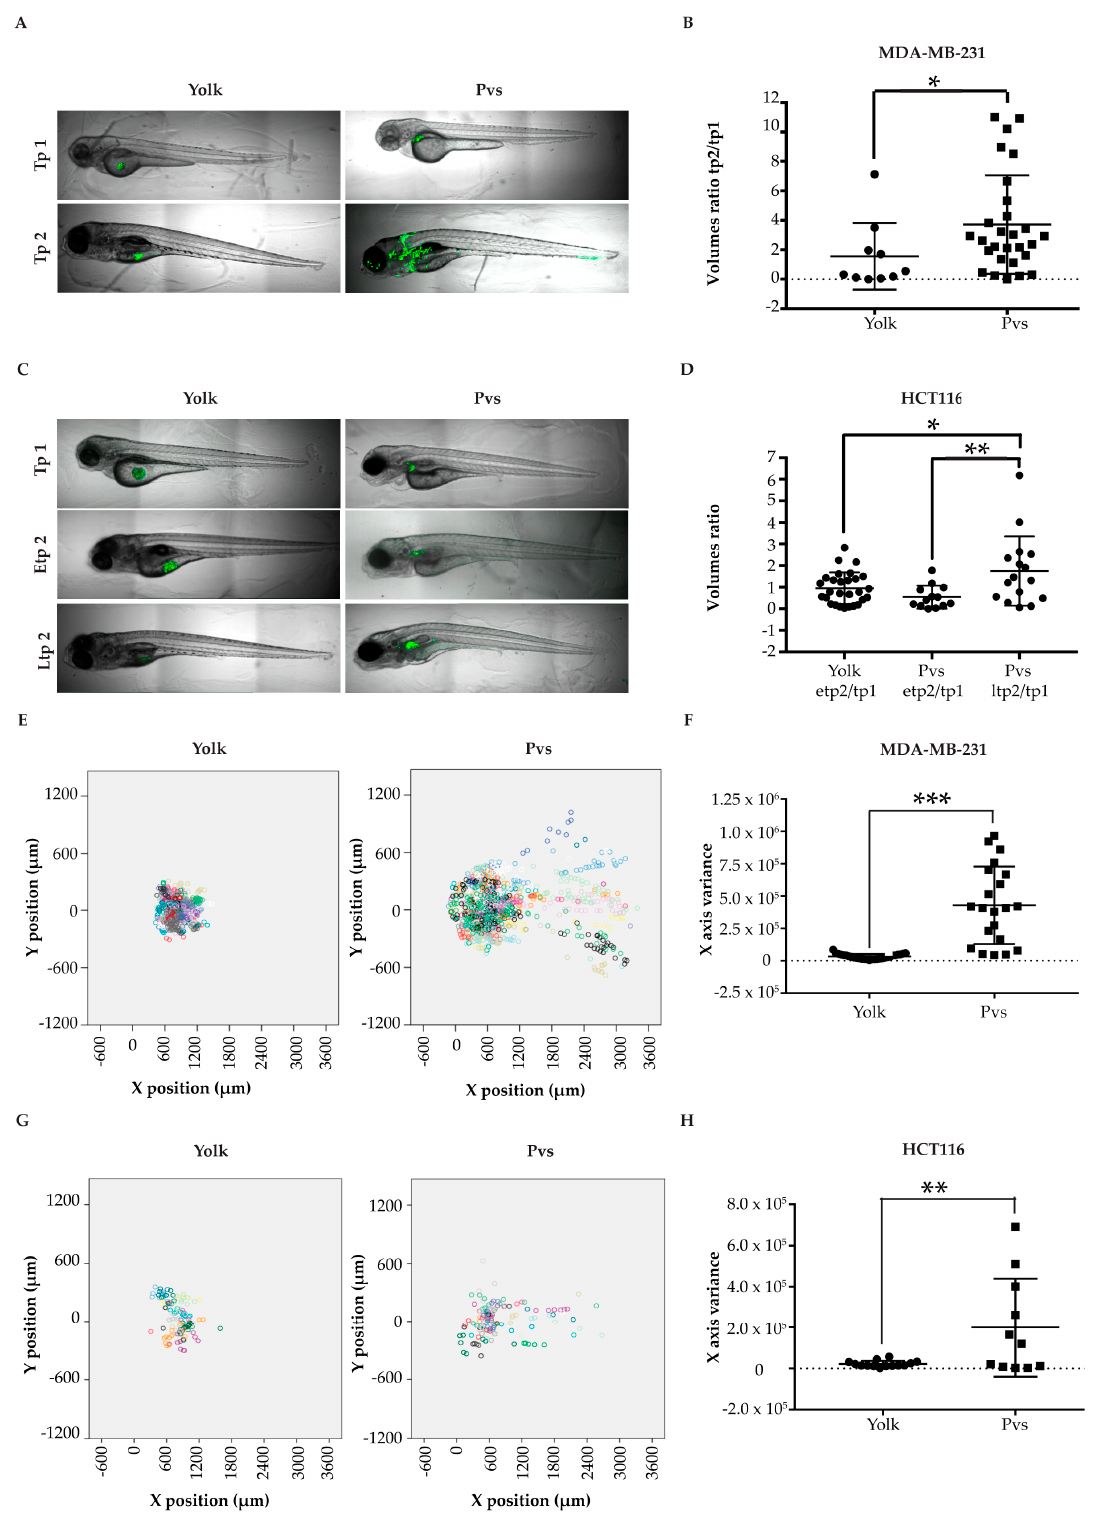
Figure 3 . Injection sites comparison. ( A ) representative images of larvae injected with MDA-MB-231 cells in the yolk and in the pvs, at two different timepoints; ( B ) scatter dot plot of the tumor masses ratios between tp2 and tp1, for each larva. Tp1 corresponds to 2 hpi and tp2 to 96 hpi; ( C) representative images of larvae injected with HCT116 cells in the yolk and in the pvs, at three different timepoints; ( D ) scatter dot plot of the volume ratios etp2/tp1 and ltp2/tp1 for each larva. Tp1 corresponds to 24 hpi, etp2 to 96 hpi and ltp2 to 144 hpi. ( E , G ) Dot plots showing MDA-MB-231 ( E ) and HCT116 cells ( G ) dissemination in injected larvae in the yolk and pvs at tp2. Each larva is depicted by a different color. Each dot corresponds to the location of a given segmented tumor mass